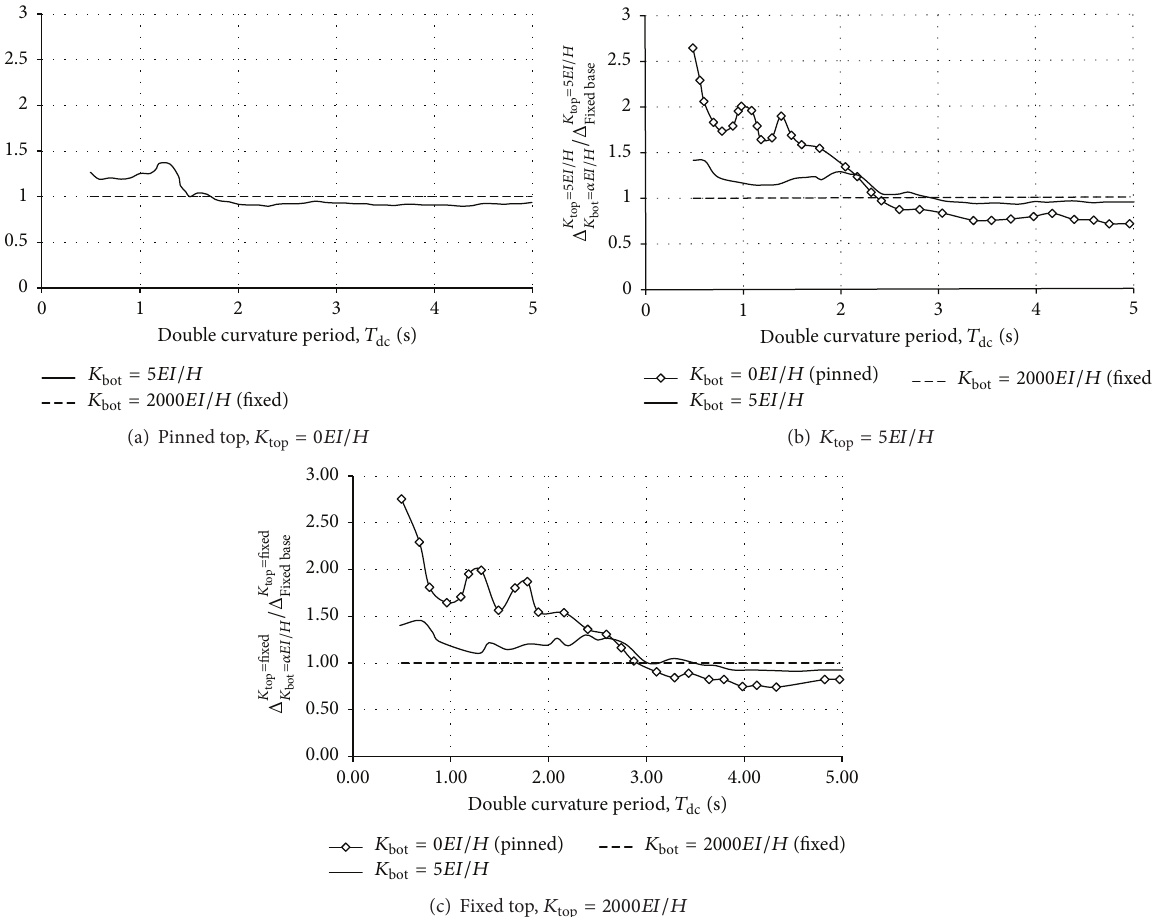
Figure 6: Base flexibility effect on top displacement for various period (elastic analysis: 𝐾